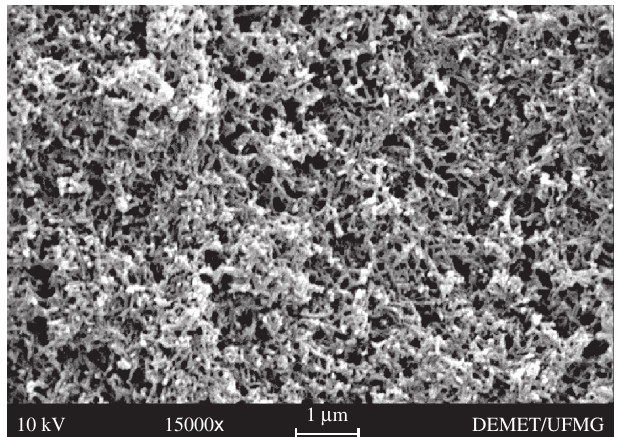
Figure 1. SEM photomicrograph of the precipitated HAP particles.